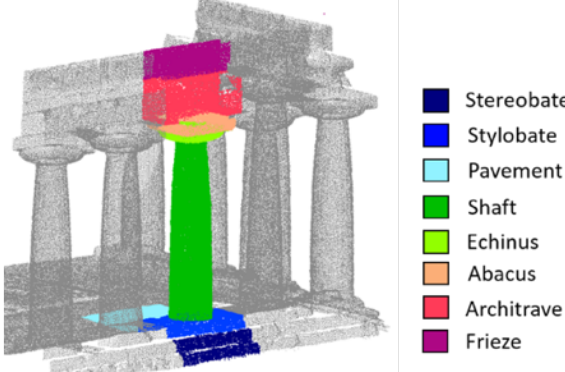
Figure 4. A portion of the Basilica point cloud manually labelled with 8